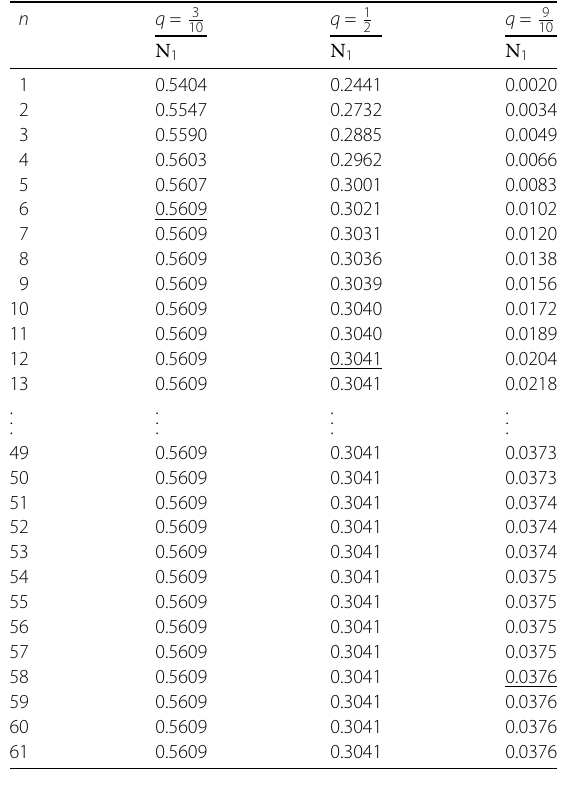
} in Example , 1 , 9 10 2 10